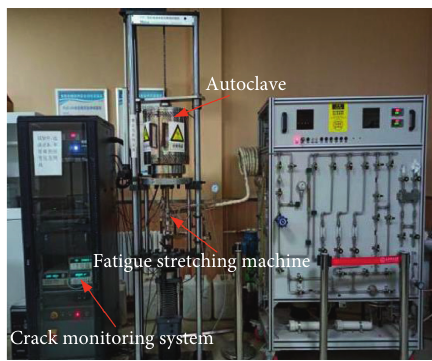
Figure 8: Experimental device for crack